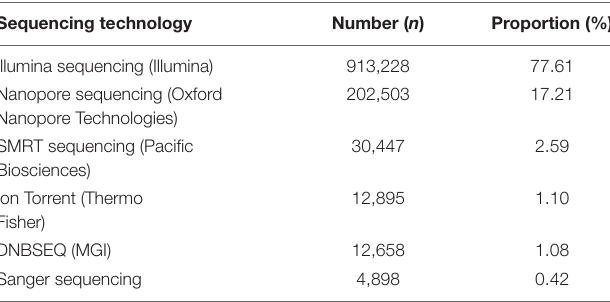
TABLE 1 | Sequencing technology used for SARS-CoV-2